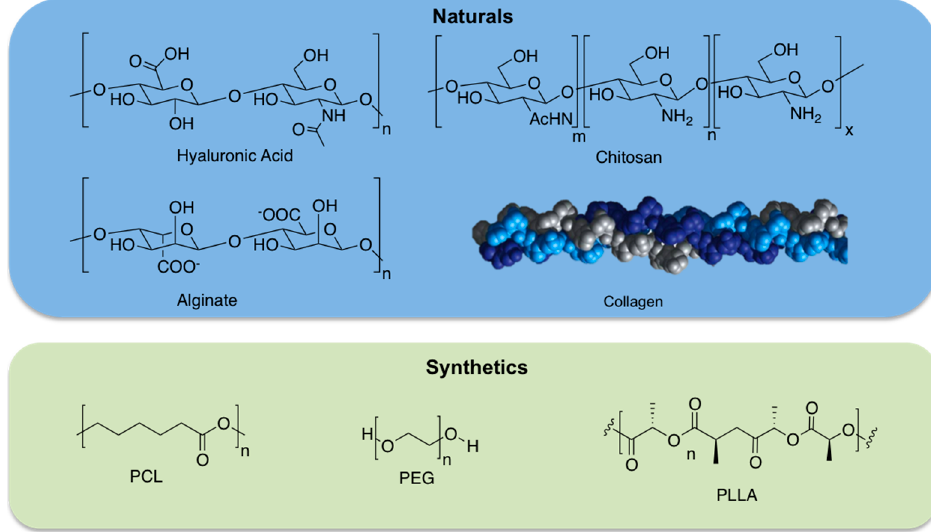
Figure 1. Chemical structure of some natural, and synthetic hydrogels.